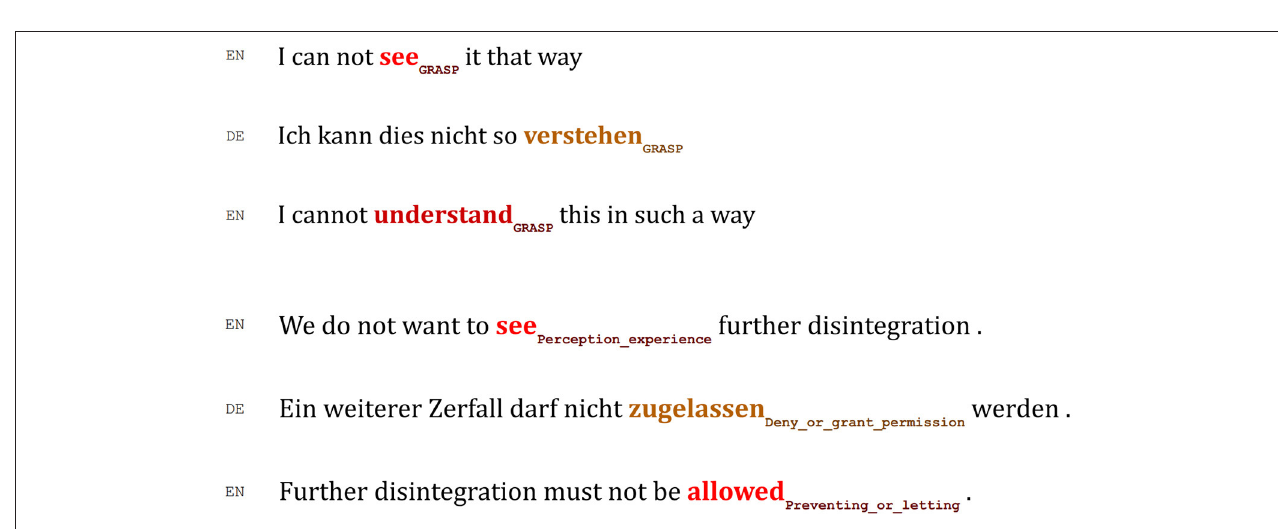
FIGURE 2 | Word aligned and semantic frame tagged sentences for language pair